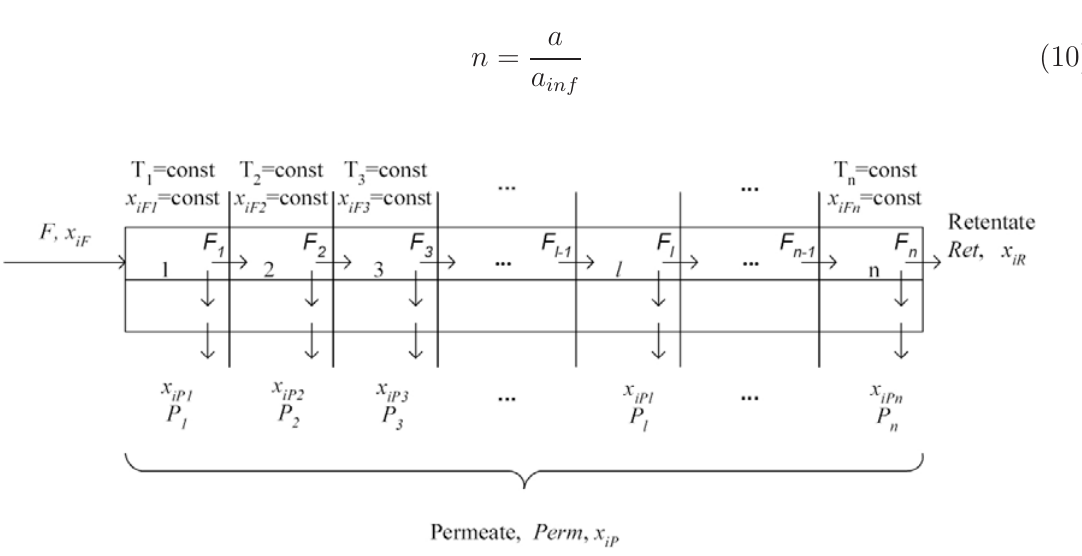
Fig. 1 Scheme for the modelling of pervaporation supposing